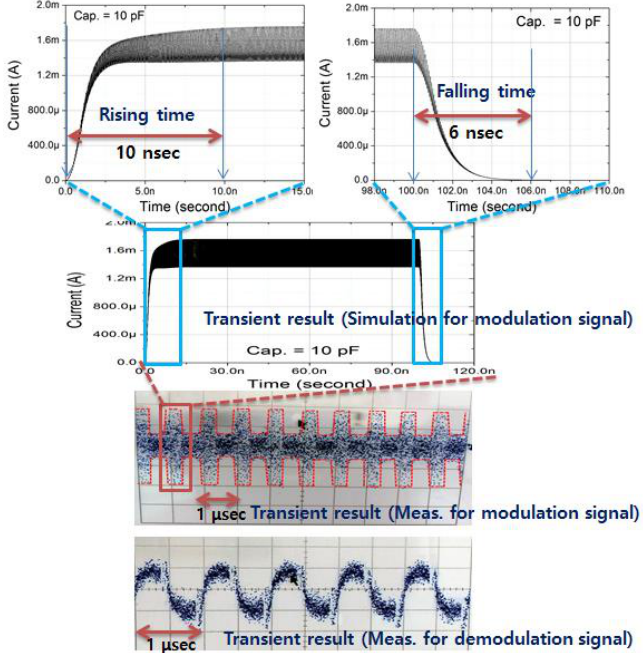
Figure 8. Transient results comparing simulation and measurement results for the modulation.